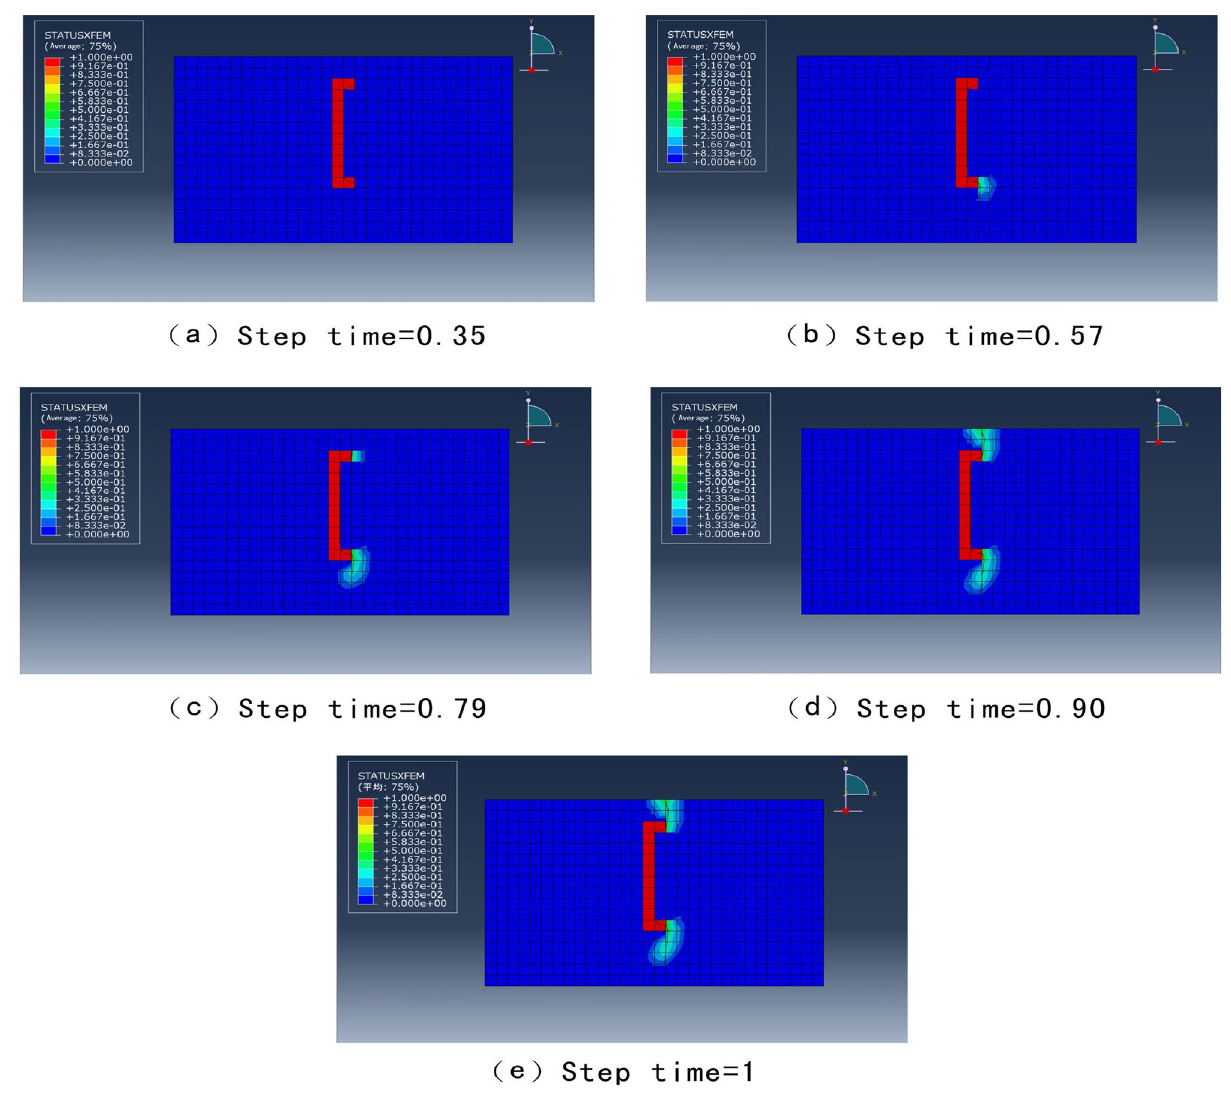
Fig. 4 Stage diagram of dry shrinkage crack extension